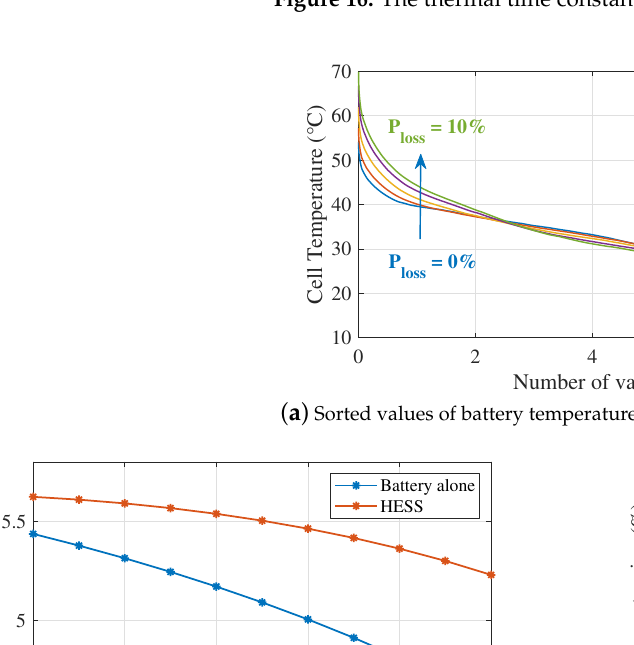
Figure 16. The thermal time constant’s effect on battery life.